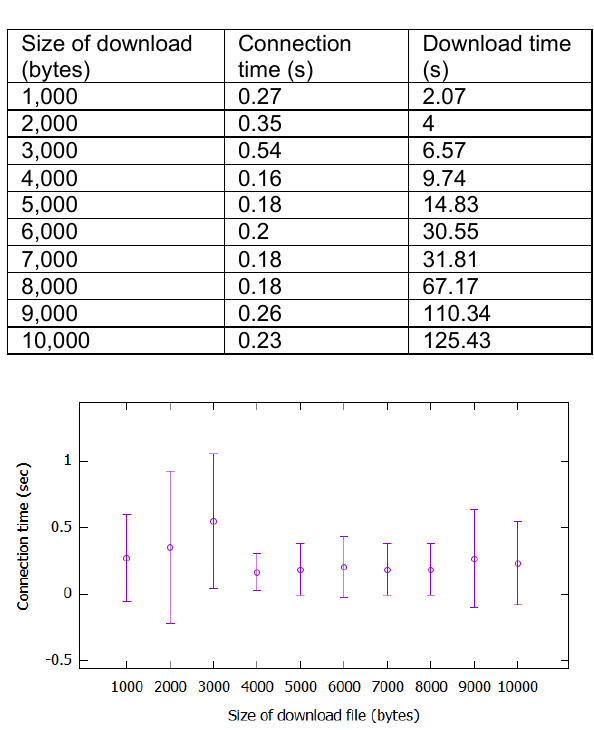
Table 3. Comparison of average HTTP download time according to the size of the download in the range of 1,000 bytes to 10,000 bytes in 100 download trials.